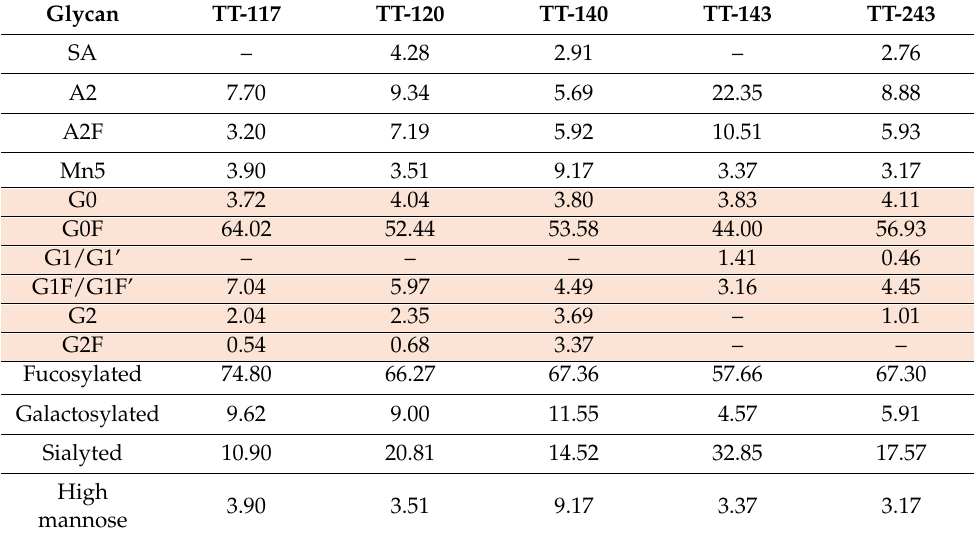
Table 2. Glycan profiles of the anti-tetanus